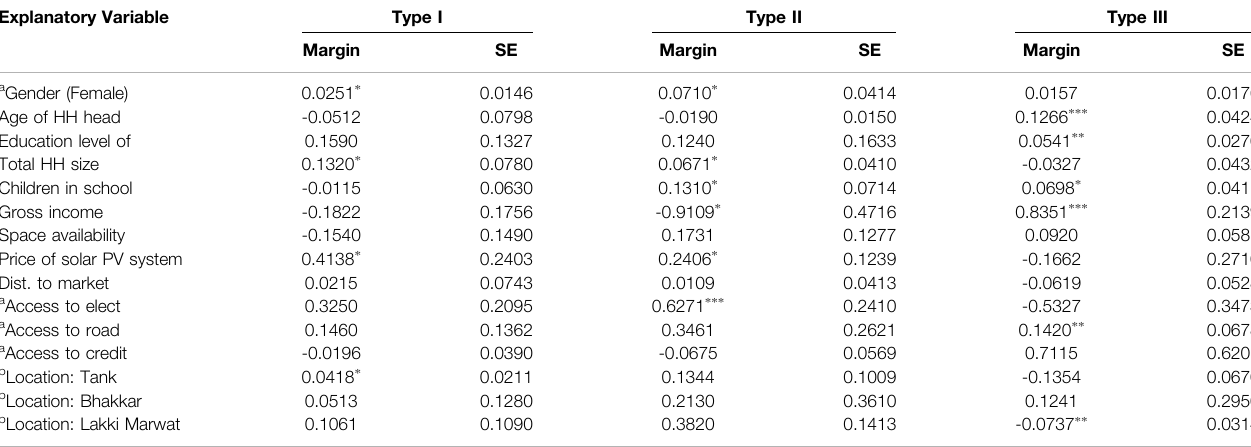
TABLE 6 | Marginal effects of explanatory variables affecting the household ’ s adoption of solar PV system types. Explanatory